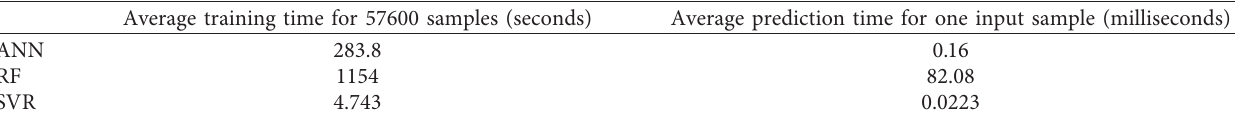
Figure 7: Traffic volume prediction on April 25, 2016, a public holiday in New Zealand (ANZAC day). Table 6: Training and testing time for each of the three learned models for short-term traffic prediction. Results indicate that these learned models will scale well for short-term predictions in large road networks.